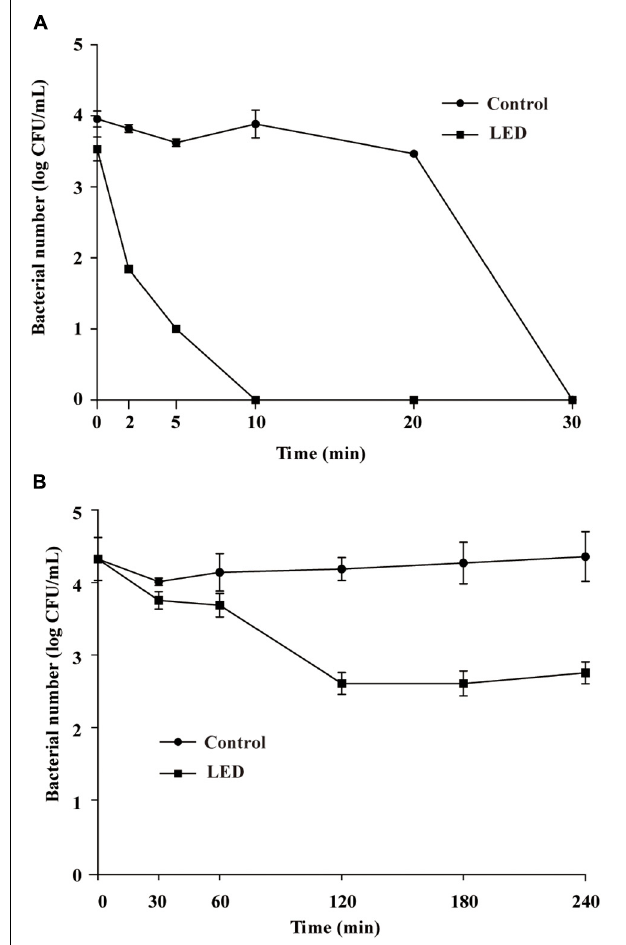
FIGURE 4 | Survival of LED-illuminated and unilluminated L. monocytogenes in SGF at pH 2.5 (A) , and in 2% (w/v) bile salt solution (B)